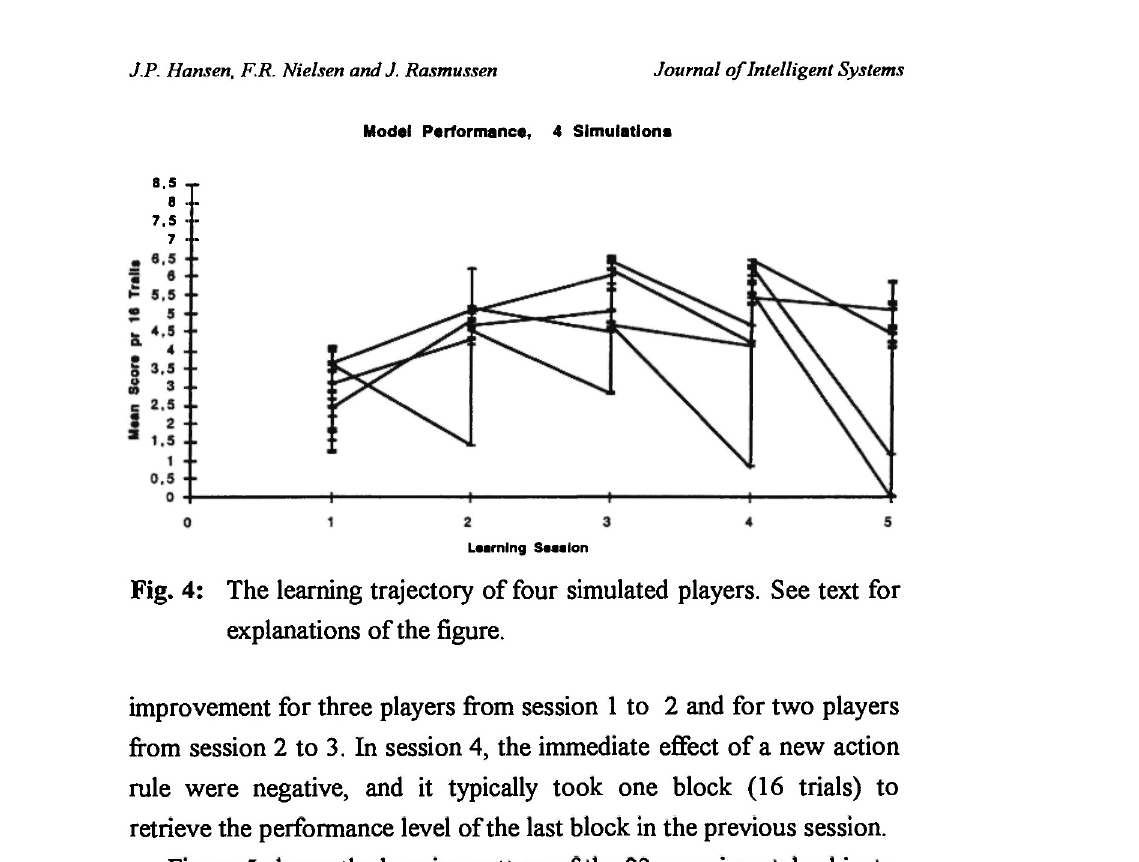
Fig. 4: The learning trajectory of four simulated players. See text for explanations of the